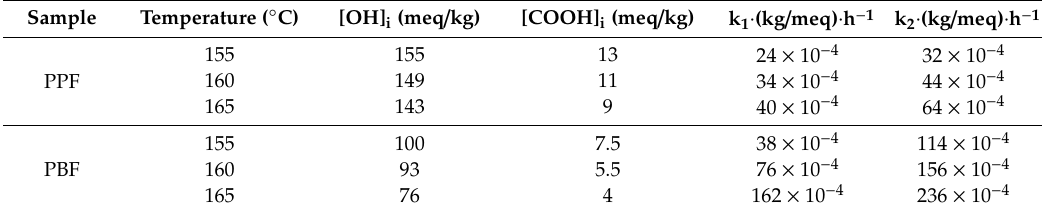
Table 2. Kinetic rate constants of the polycondensation/transesterification (k 1 ) and esterification (k 2 ) reactions and concentration of temporarily inactivated OH and COOH end-groups at different reaction temperatures for PPF and PBF polyesters.